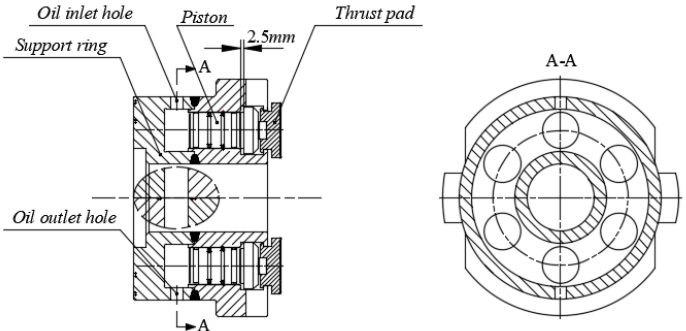
Figure 2. Friction damper integrated into the thrust bearing.